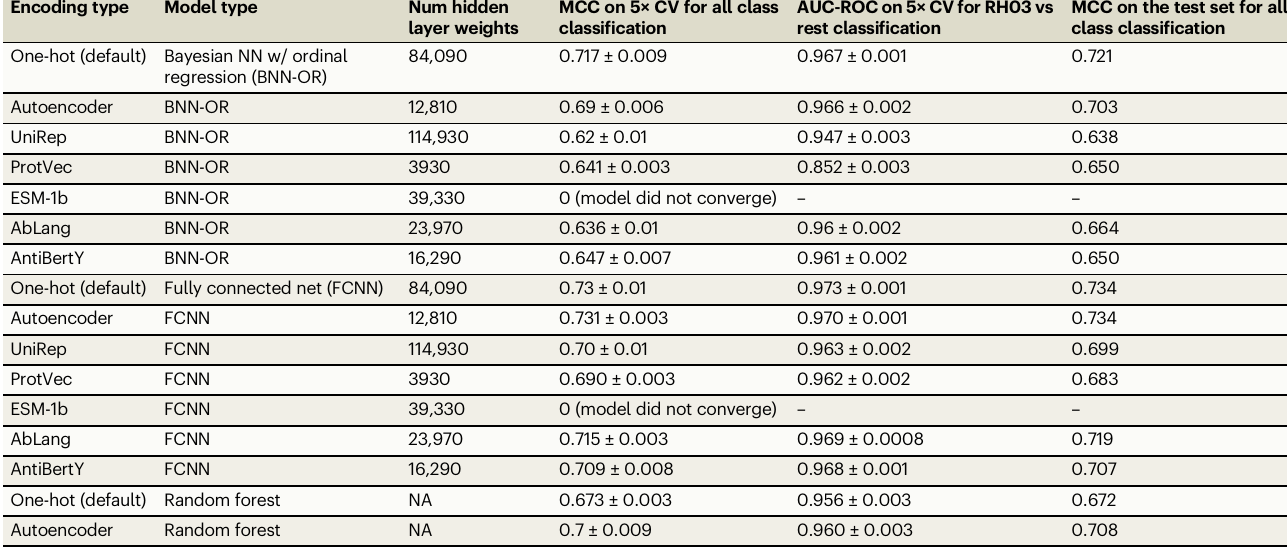
Table 1 | Performance comparisons across different encoding types and model architectures for classi fi cation performance on the Atezolizumab dataset